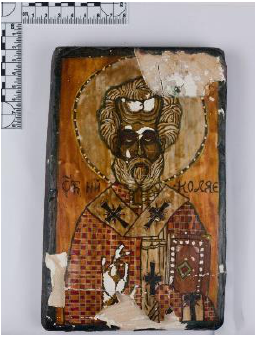
Figure 3. St. Nicholas icon with scale. Colour corrected